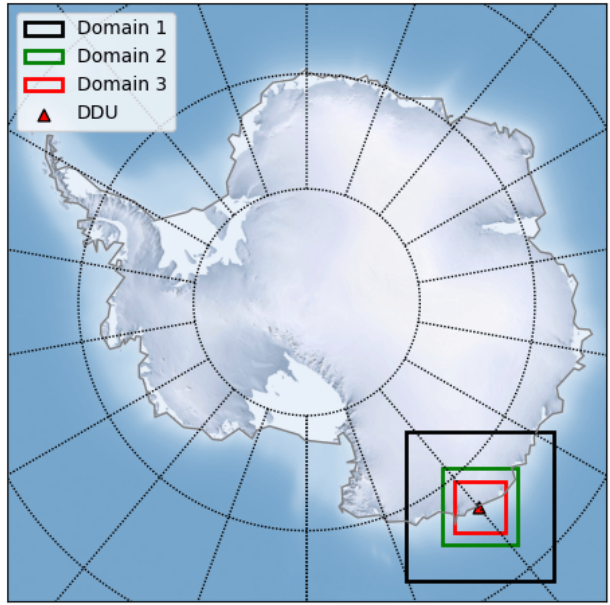
Figure 9. Simulation domains for case study Ib (coloured rectan- gles). The three nested domains of 12km (black), 4km (green), and 1km (red) resolution. These domains are centred at the Dumont d’Urville (DDU) station (red